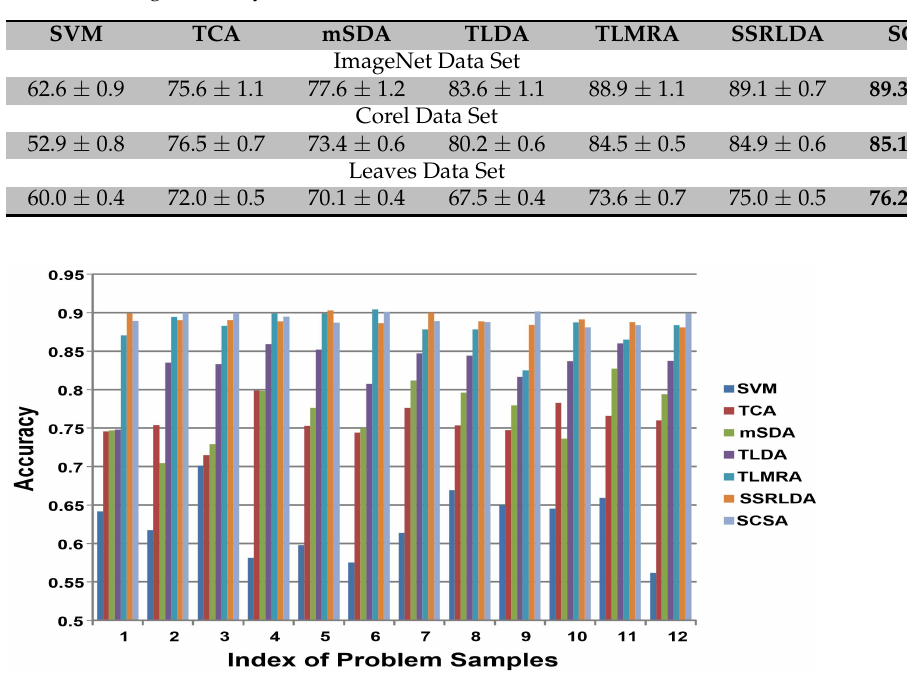
Figure 2. Performances on ImageNet dataset. The y-axis represents the classification accuracy of the target domain; the x-axis represents the index of the problem sample.